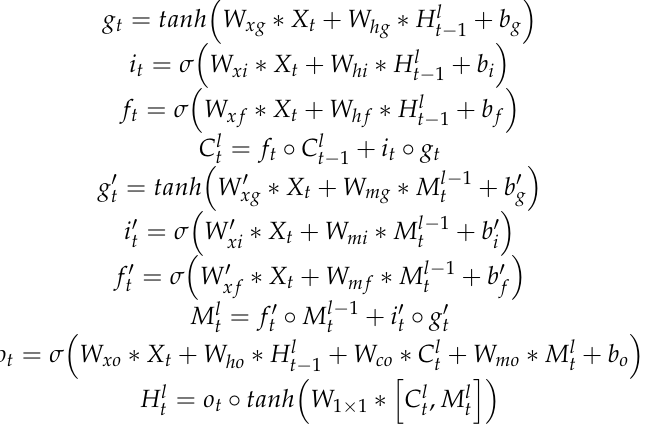
Figure 1. The architecture of the ST-LSTM unit (left) and the PredRNN model (right). The 𝑋 𝑡 , 𝐻 𝑡 , 𝑀 𝑡𝑙 and 𝐶 𝑡𝑙 in the left panel are the data image, the hidden state, the spatiotemporal memory cell and the standard temporal memory cell, respectively. 𝑖 , 𝑓 , 𝑔 and 𝑜 indicate the input gate, the forget gate, the input-modulation gate and the output gate. The orange arrows in the right panel denote the spatiotemporal memory flow, namely the transition path of the spatiotemporal memory cell 𝑀 𝑡𝑙 in the left panel.